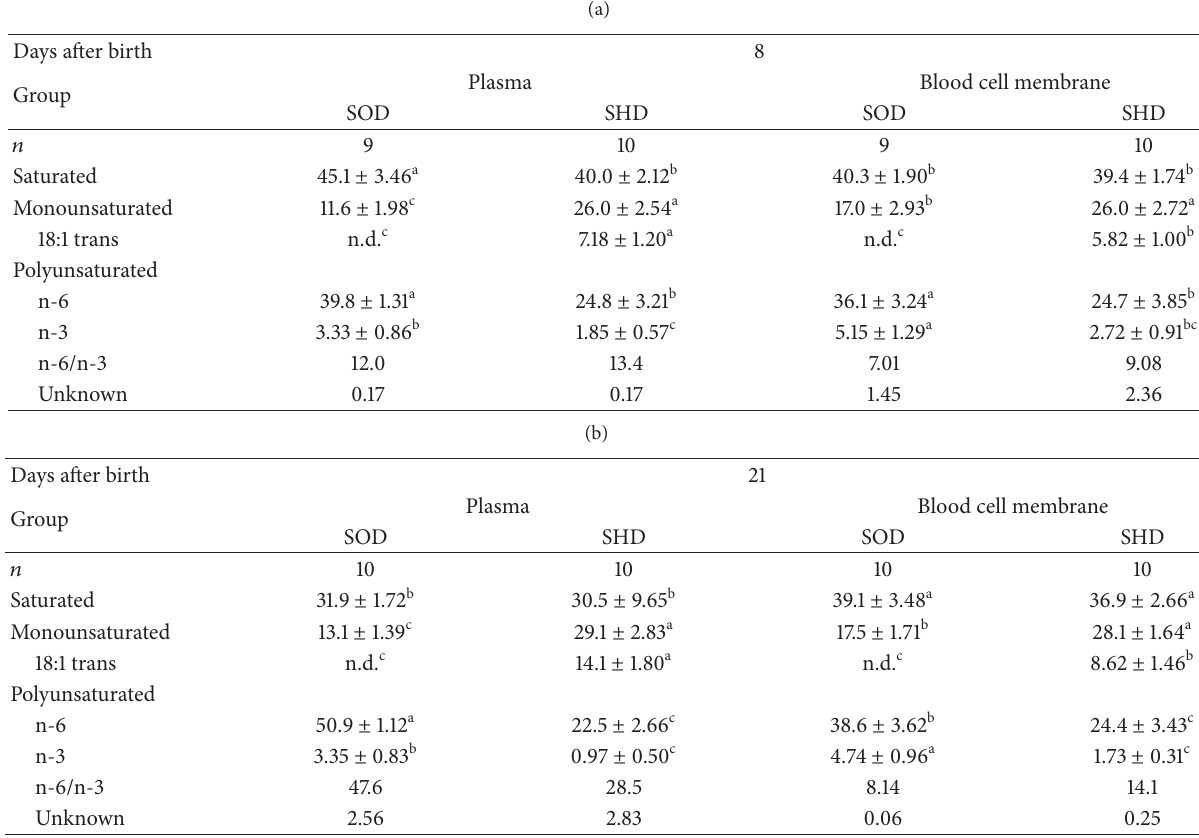
Table 7: Fatty acid compositions of the plasma and blood cell membrane of pups, on days 8 and 21 after birth, nursed by dams fed the soybean oil or shortening diet.